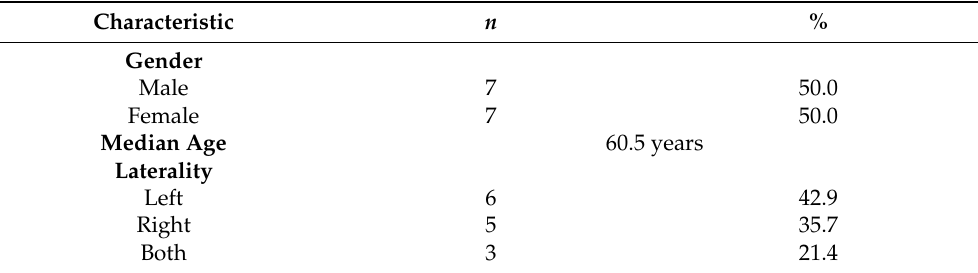
Table 1. Baseline demographic and clinical characteristics of the study patients ( n =